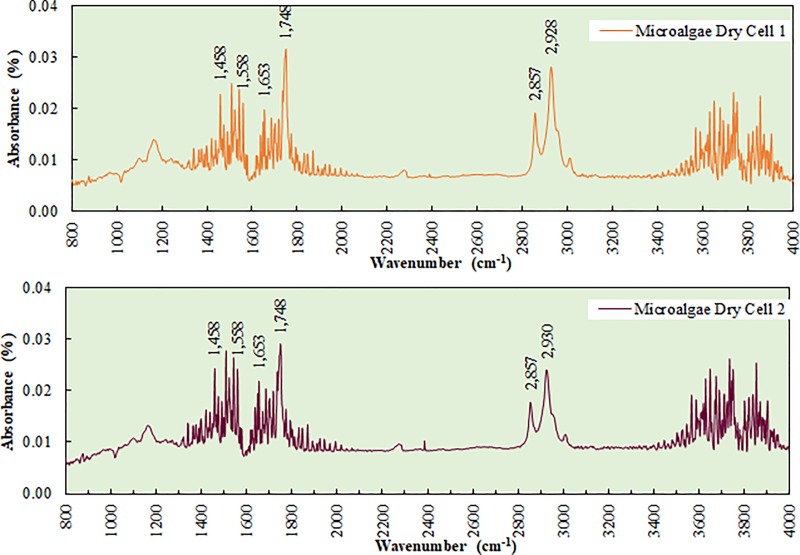
FTIR absorbance spectrum on microalgae dry cell samples.